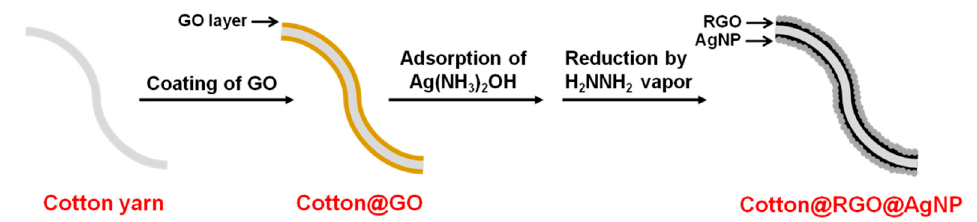
Figure 1. Schematic illustration of the synthetic process of cotton-RGO-AgNP hybrid